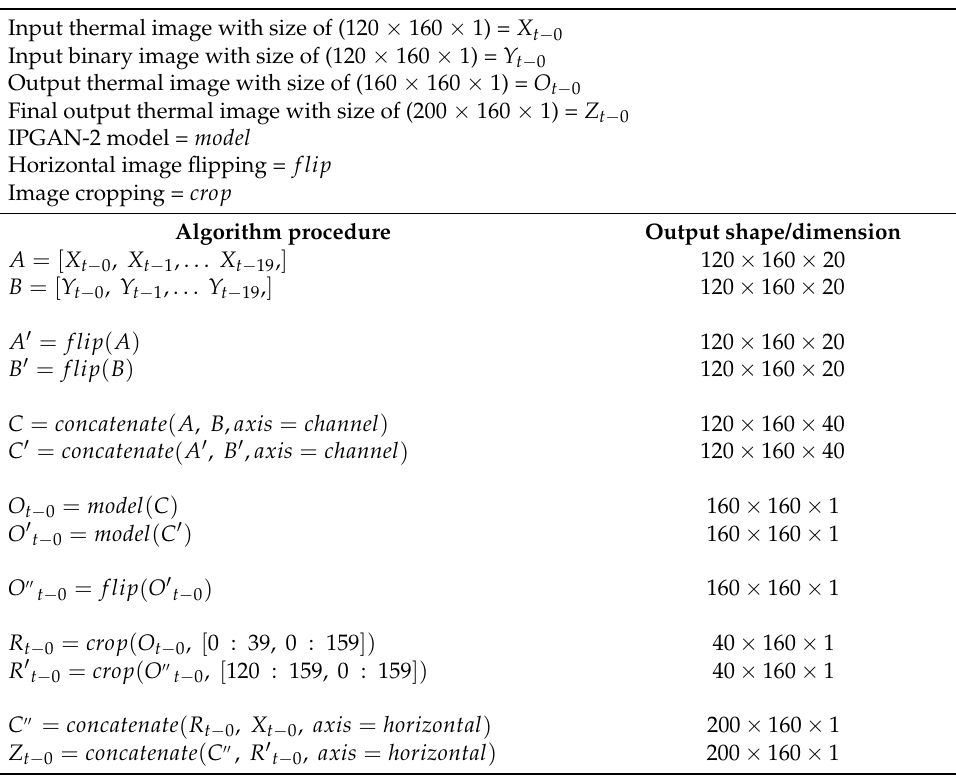
Table 2. The proposed method detailed by using pseudo